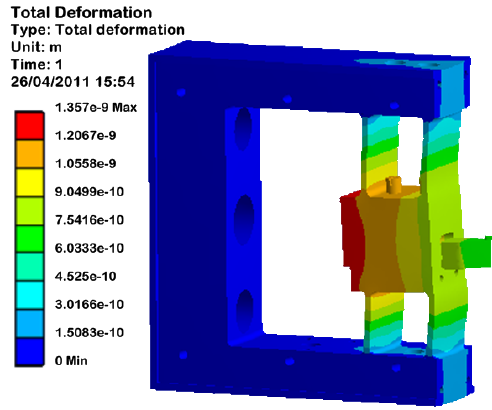
Figure 6. Deformation of the CM structure only subjected to Figure 6: Deformation of the CM structure only subjected to gravity